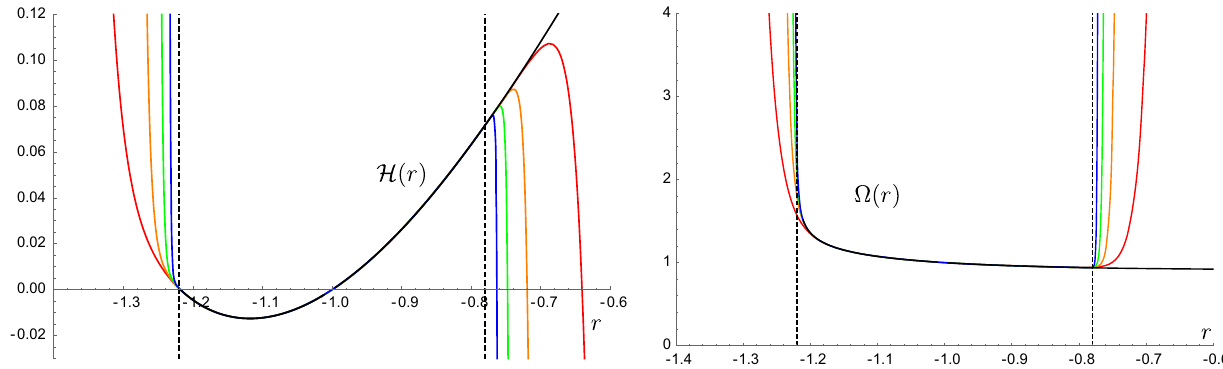
Fig. 1 Series (67) and (68) for the metric functions H ( r ) (left) and (cid:10)( r ) (right) for the first 20 (red), 50 (orange), 100 (green), and 200 (blue) terms and a numerical solution (black) of (32) and (33) for val- ues (cid:9) = 0, (cid:2) = 0 . 2, r h = − 1, k = 0 . 5, b = 0 . 3 (recall the gauge (59) is used here). From further analysis (not represented in the above figures, cf. [17,20] in the case (cid:9) = + 1), the coefficients α i and γ i seem to be approaching geometric series for large values of i . This allows us to estimate the radius of the convergence and the interval of convergence indicated, in both graphs, by the two vertical dashed lines. Note that,